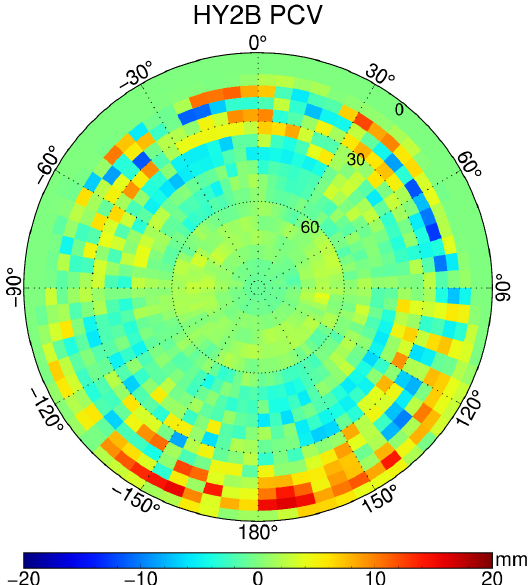
Figure 7. Estimated azimuth elevation diagrams of the 5° × 5° PCV patterns for the HY-2B satellite.